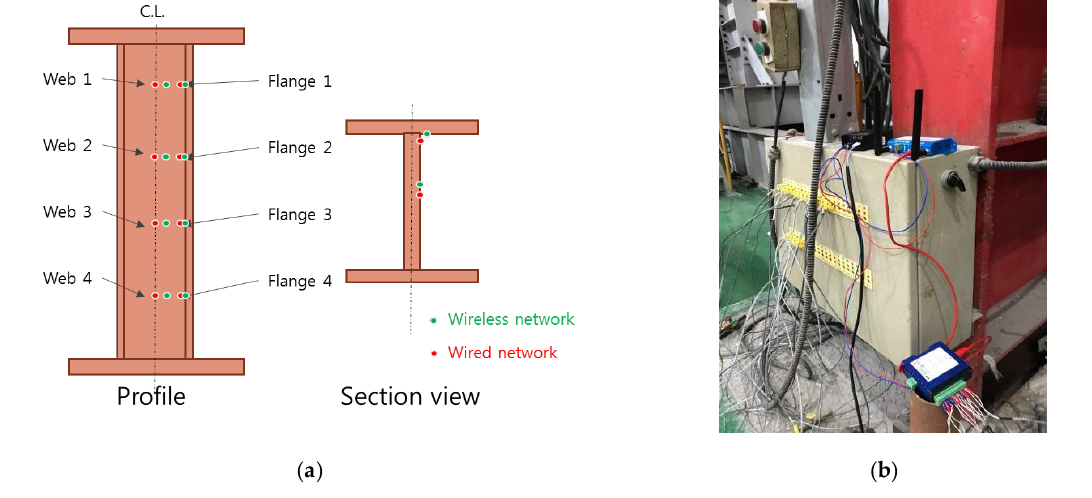
Figure 5. Sensor topology and network installation for the network validation: ( a ) sensor locations, ( b ) converter and transmitter.